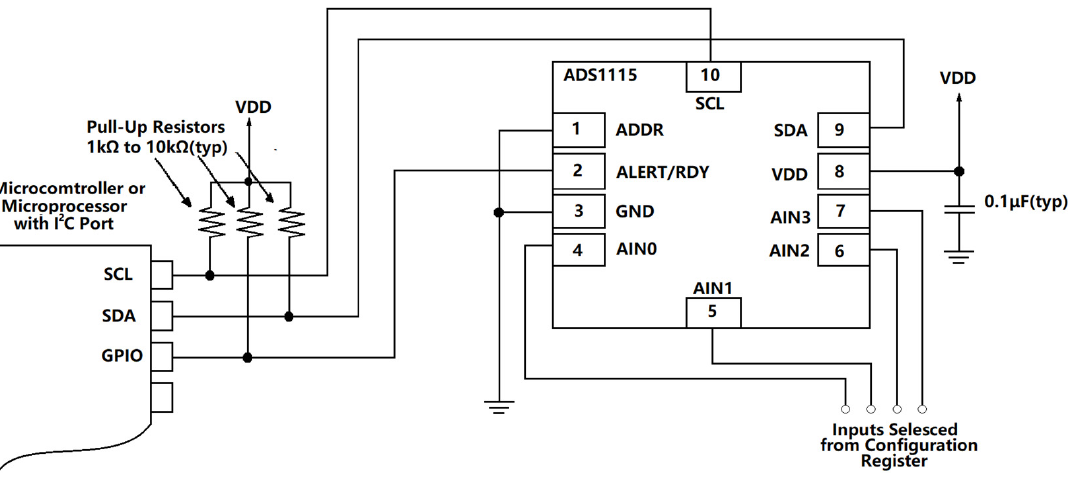
Figure 7. ADS1115 A/D conversion module.